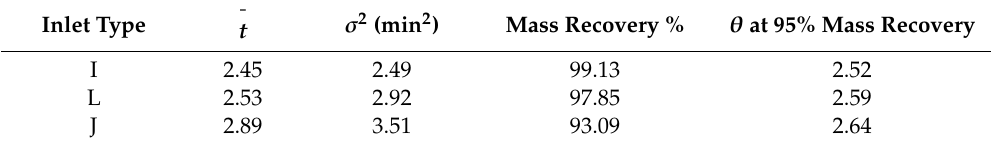
Table 3. Mean residence time, variance of RTD, and mass recovery for all types of inlet.